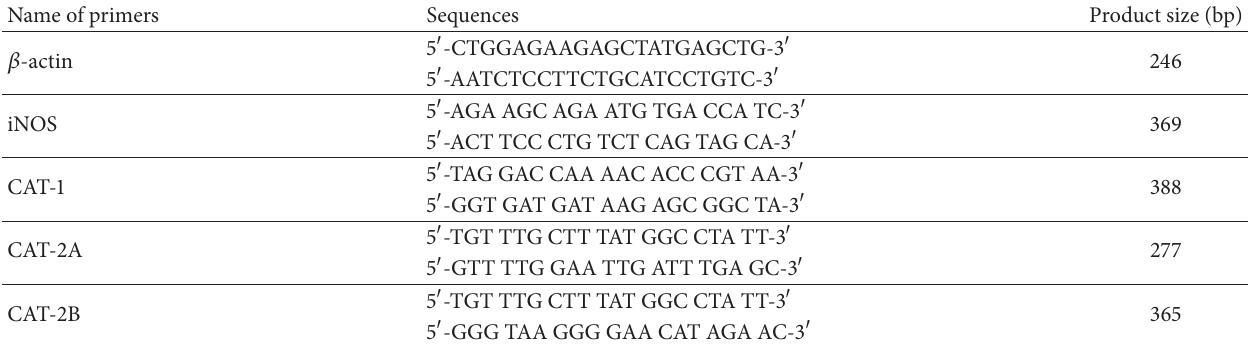
Table 1: Sequences of primers used in